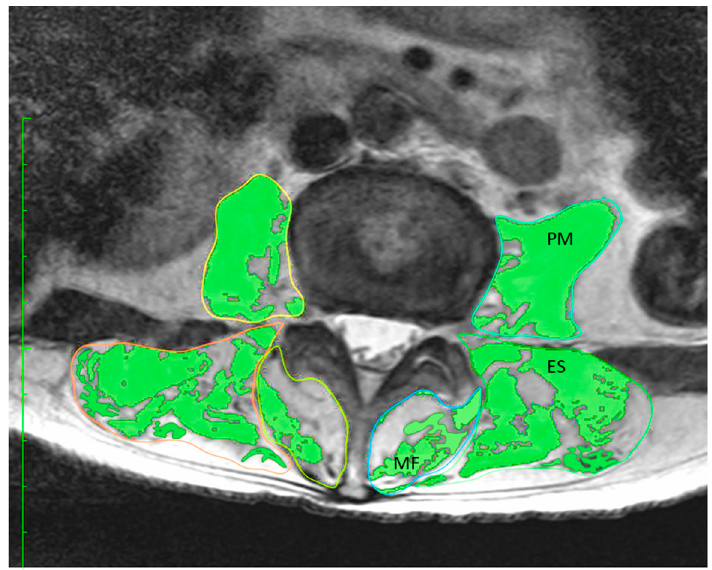
Figure 7. Case presentation 2. A 70-year-old female with severe low back pain. The patient’s CSA of PVM and fat-free PVM was 36.59 and 20.02 cm 2 , respectively. The fat-free percentage of PVM was 54.7%. TMM–BIA, trunk muscle mass measured by bioelectrical impedance analysis; CSA, cross-sectional area; PVM, paravertebral muscles.